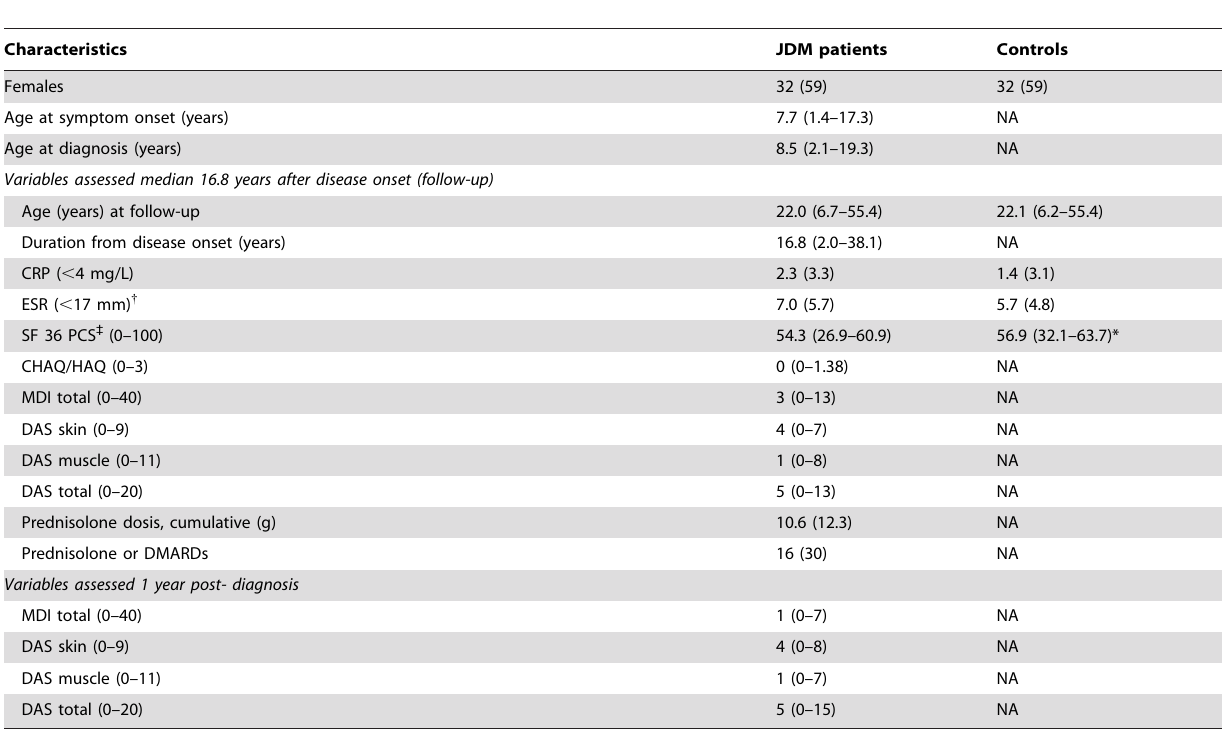
Table 1. Characteristics and disease parameters in 54 patients with juvenile dermatomyositis and in 54 controls.